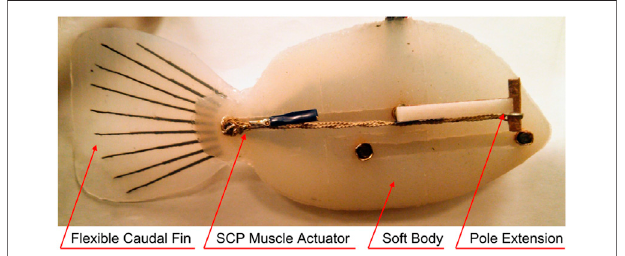
FIGURE 2 | Soft robotic fi sh with passive caudal fi n, bundled SCP actuator and pole extensions attached.